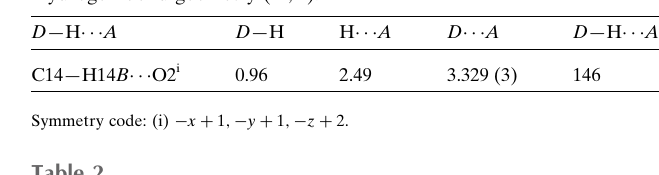
Table 1 Hydrogen-bond geometry (A˚ , (cid:2) ).